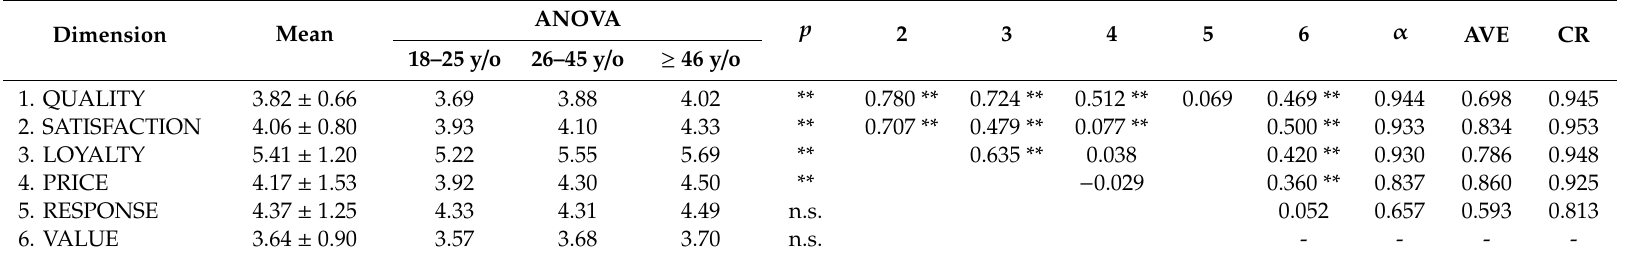
Table 2. Means, standard deviations, ANOVA, and significance levels. Correlations, Cronbach’s alpha, AVE, and CR.